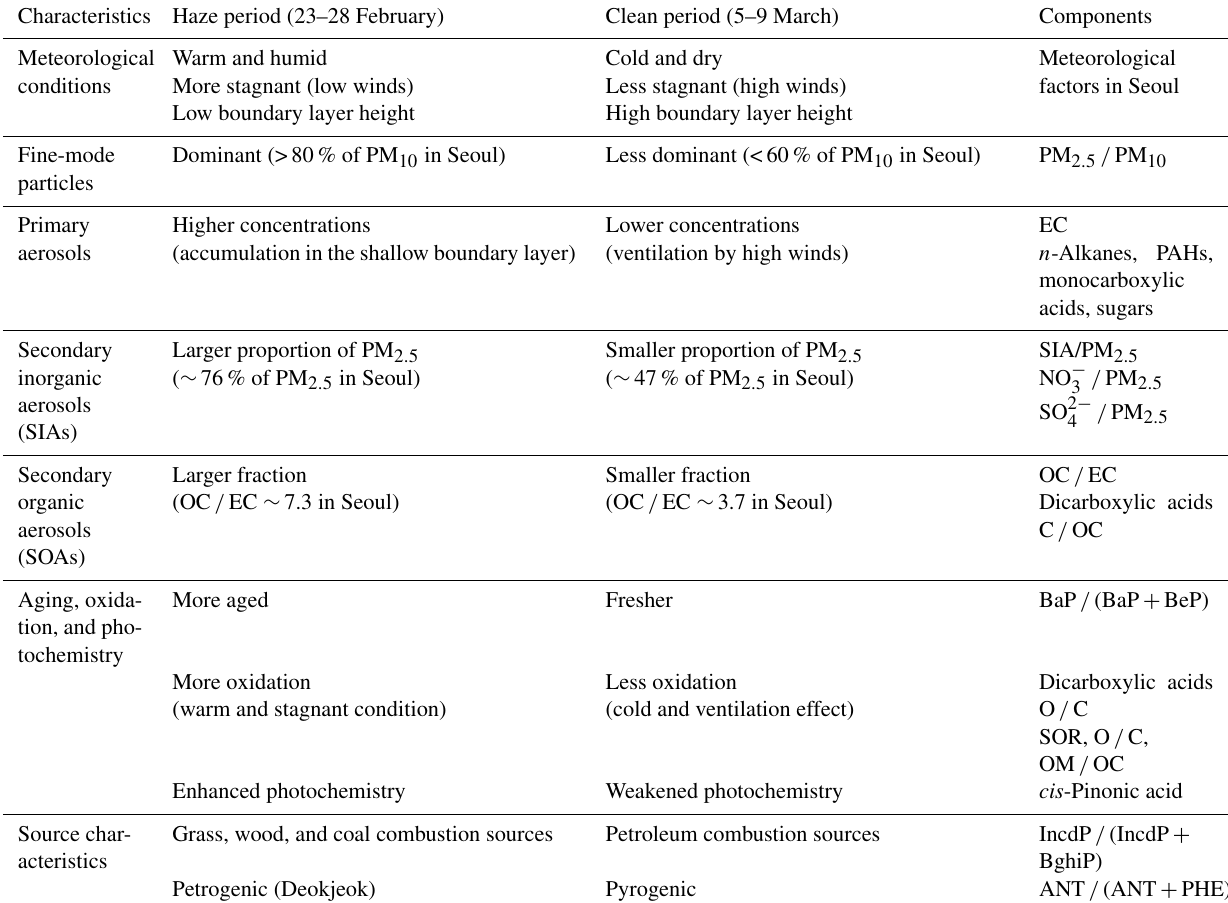
Table 4. Comparisons of meteorological conditions and properties of PM 2 . 5 between the haze and clean periods. Characteristics Haze period (23–28